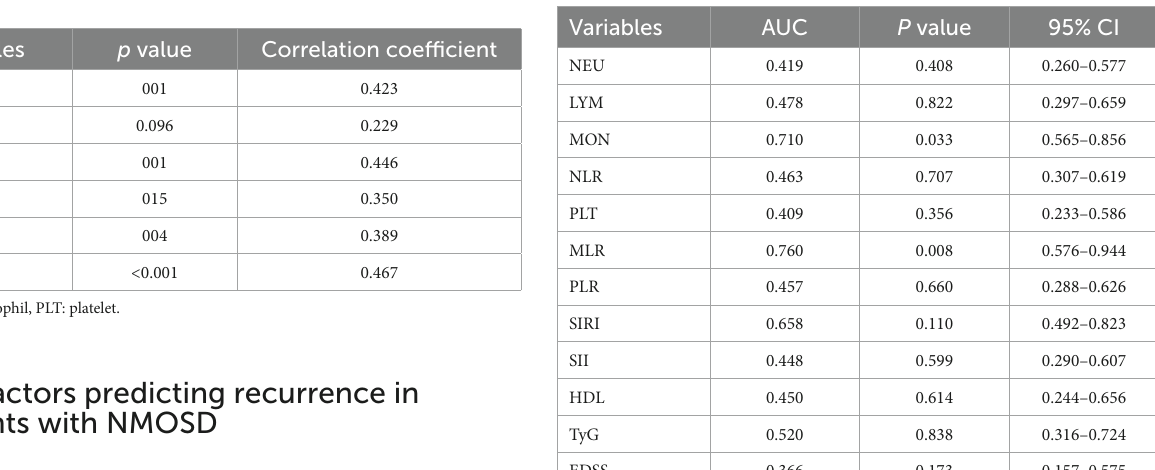
TABLE 3 ROC curve analysis for predicting